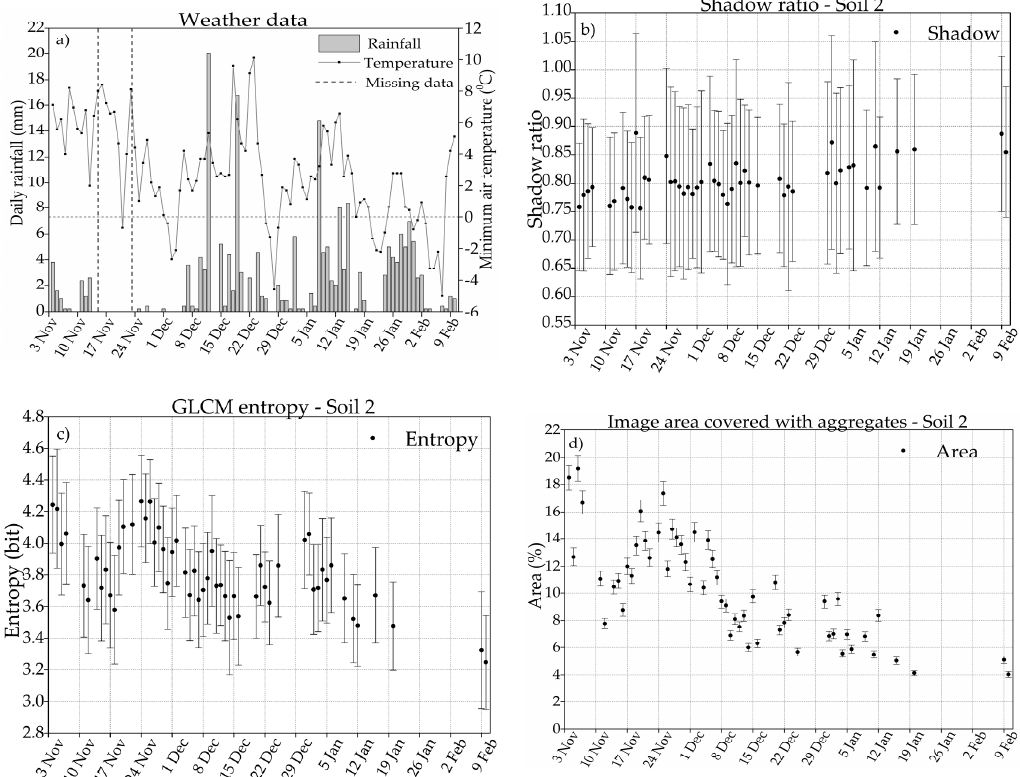
Figure 6. Weather data ( a ) together with shadow ratio ( b ); entropy ( c ); and area ( d ) results of Soil 2 are shown. Gray bars and gray line indicate daily rainfall and minimum air temperature, respectively. The gray dashed horizontal line indicates the temperature in °C. The vertical black dashed lines show missing rainfall data interval from 15 to 23 November 2014. The error bars indicate the standard deviation of: shadow ratio ( b ); and entropy ( c ). The standard error bars of area ( d ) represent the 95% confidence interval of the true population mean for the sample size 56.